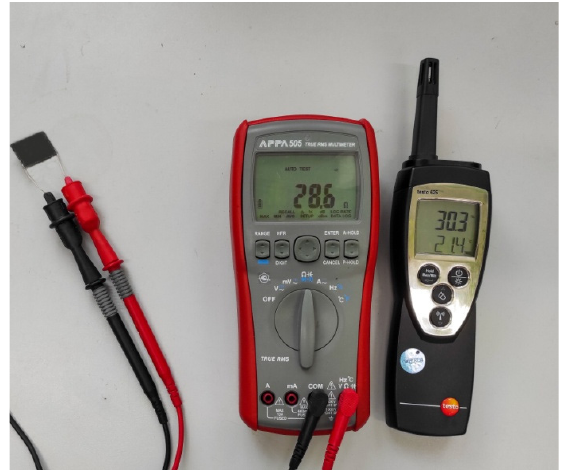
Figure A2. The photo of setup for resistance measurements.